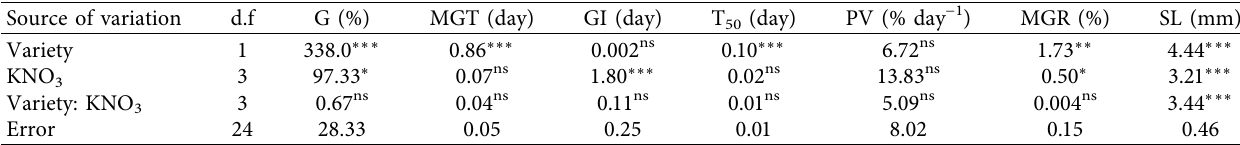
Table 1: Mean squares of analysis of variance for the effects of potassium nitrate osmopriming on germination parameters in two tomato